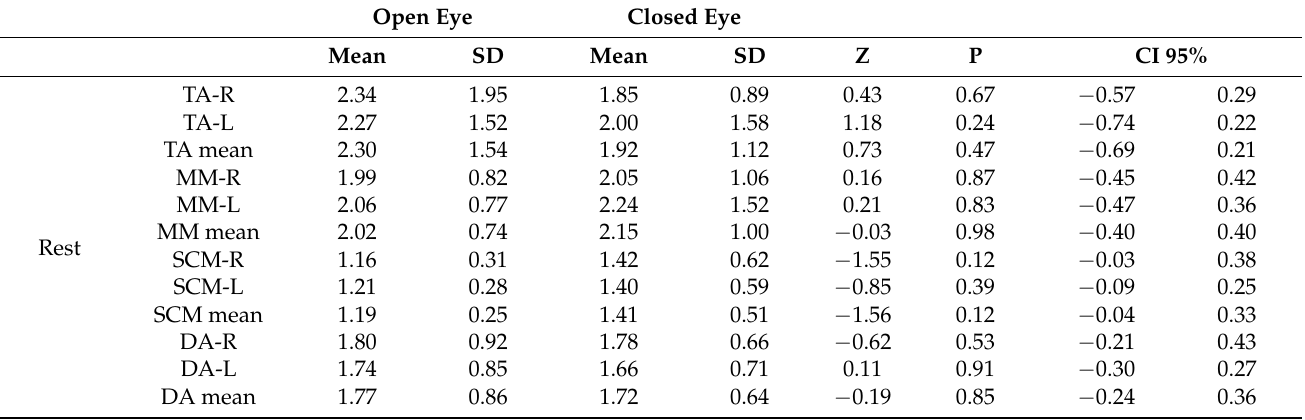
Table 2. Results of comparison of bioelectrical activity of selected muscles of the masticatory and cervical spine muscles in